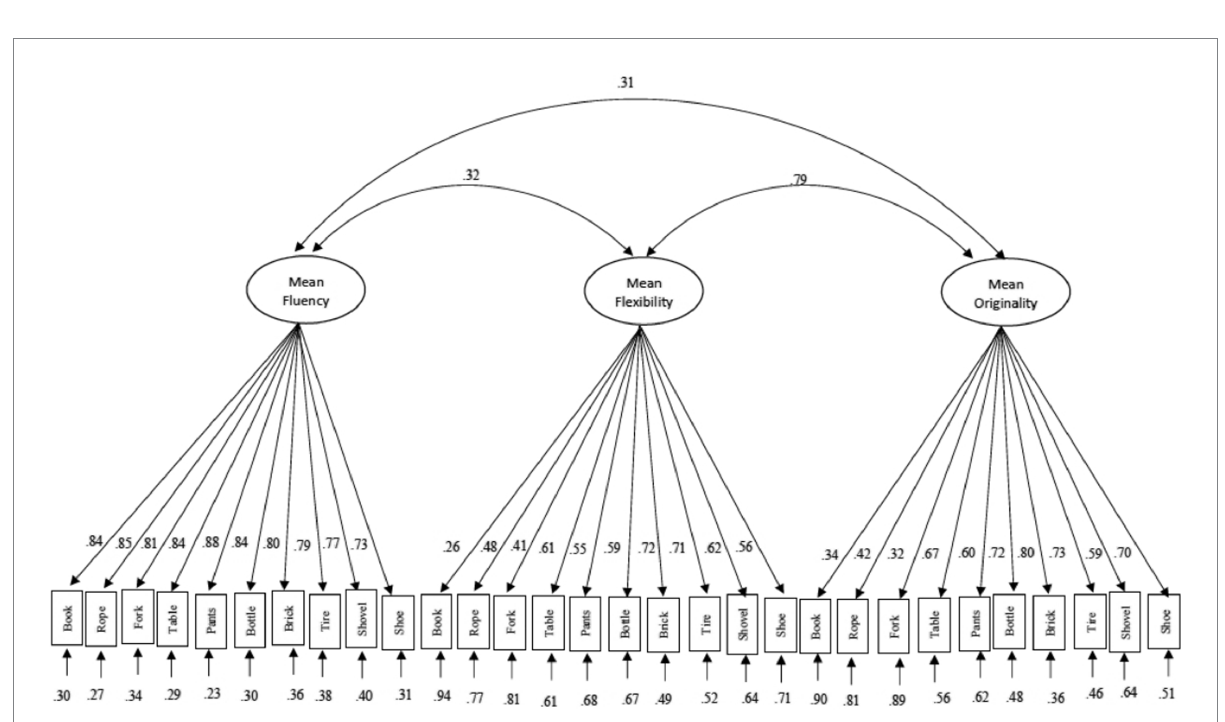
FIGURE 4 Path diagram of mean flexibility, mean originality, and fluency